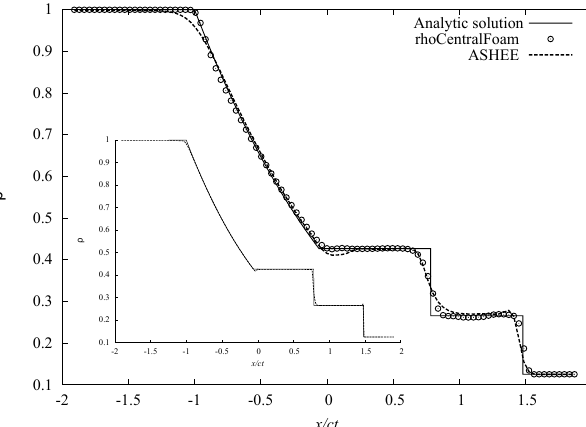
Figure 14. Centerline time-averaged axial velocity, and tempera- ture profiles with azimuthal forcing. Inset: centerline correlations of fluctuating velocity and temperature.